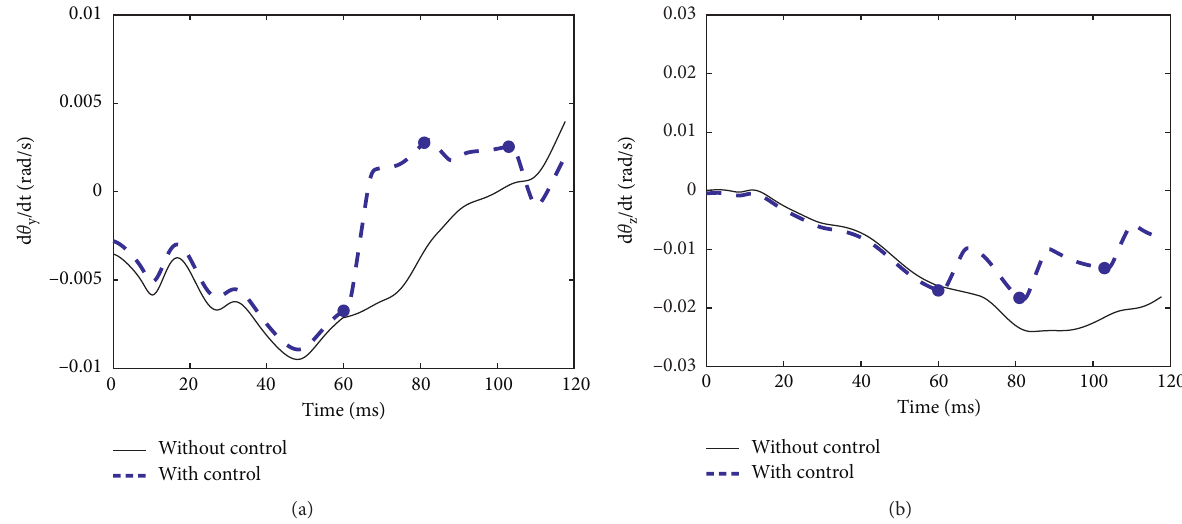
Figure 9: Simulated results of the elevation part in launching process for the 6th rocket under Condition 2: (a) the yawing angular velocity and (b) the pitching angular velocity. The blue dots indicate the action of the AAT.